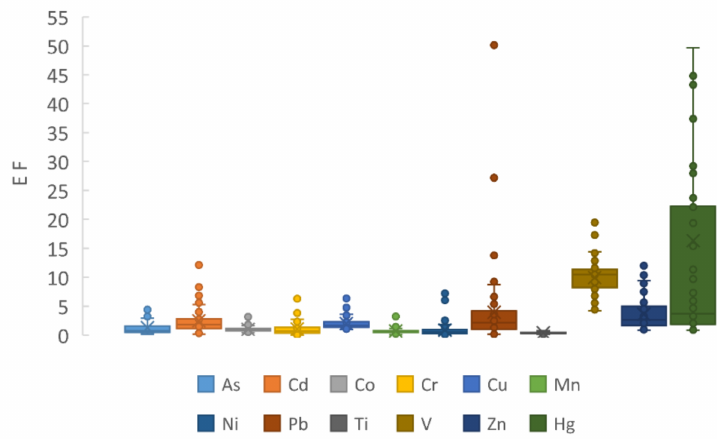
Figure 3. Enrichment factors for the studied elements relative to Cuban natural